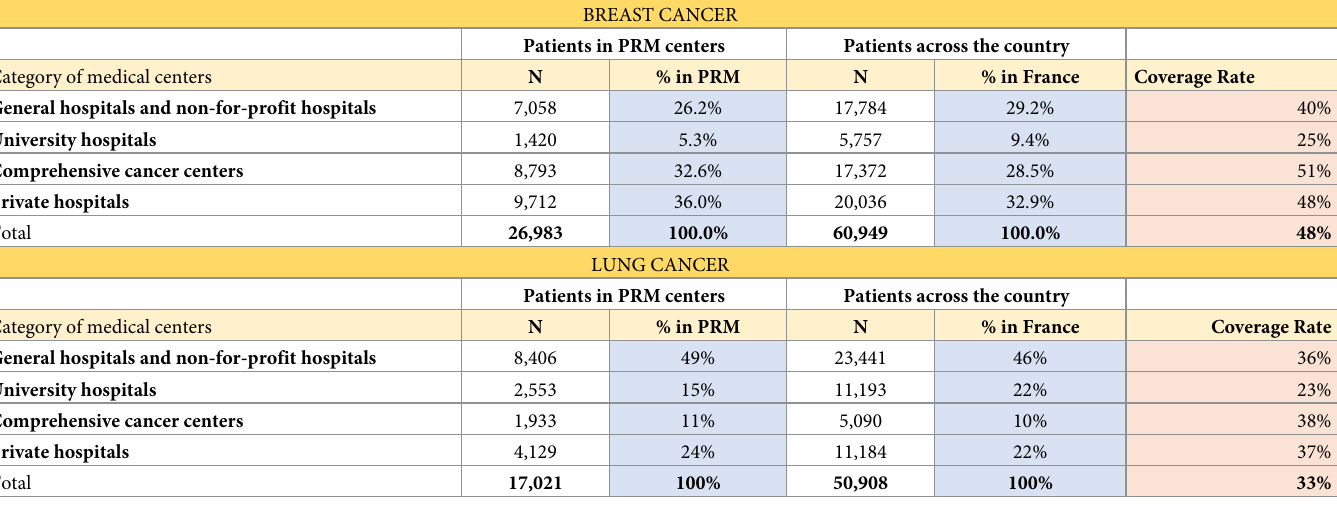
Table 2. Distribution of patients who were treated for breast cancer and lung cancer, by category of medical center, in PRM centers and in all French medical cen- ters in 2018, according to the French National Hospital database